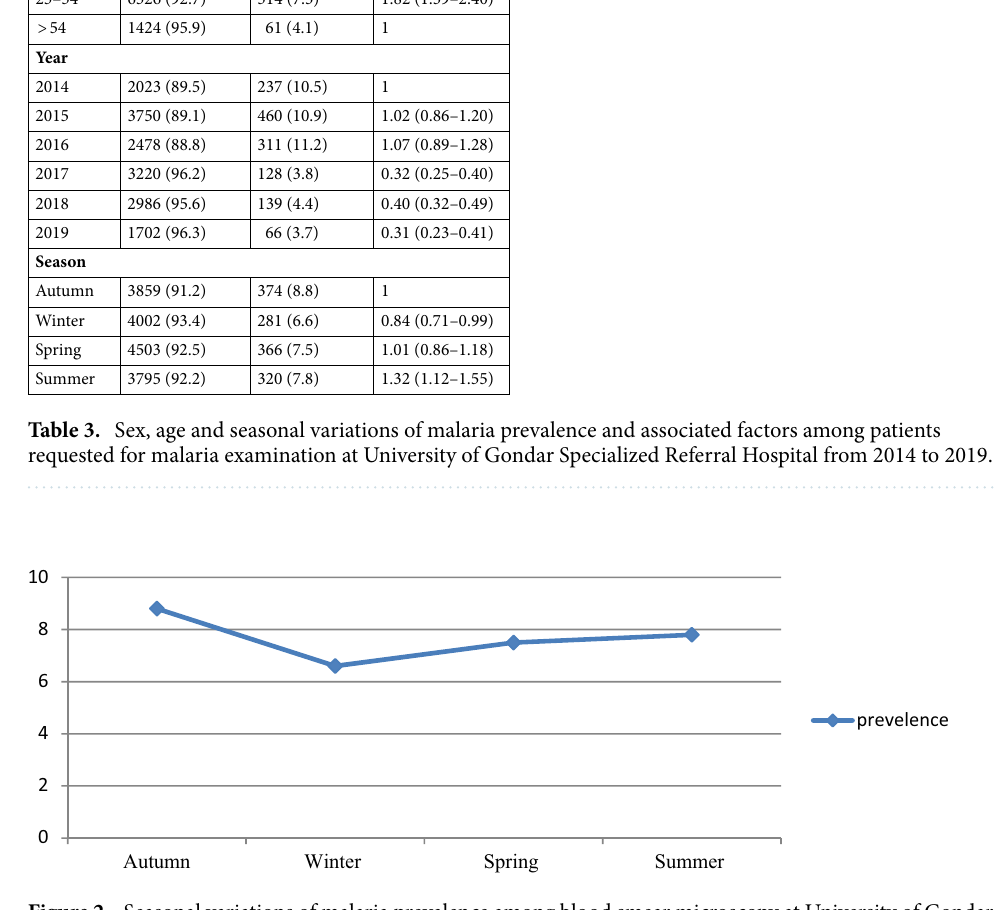
Figure 2. Seasonal variations of malaria prevalence among blood smear microscopy at University of Gondar Specialized Referral Hospital from 2014 to